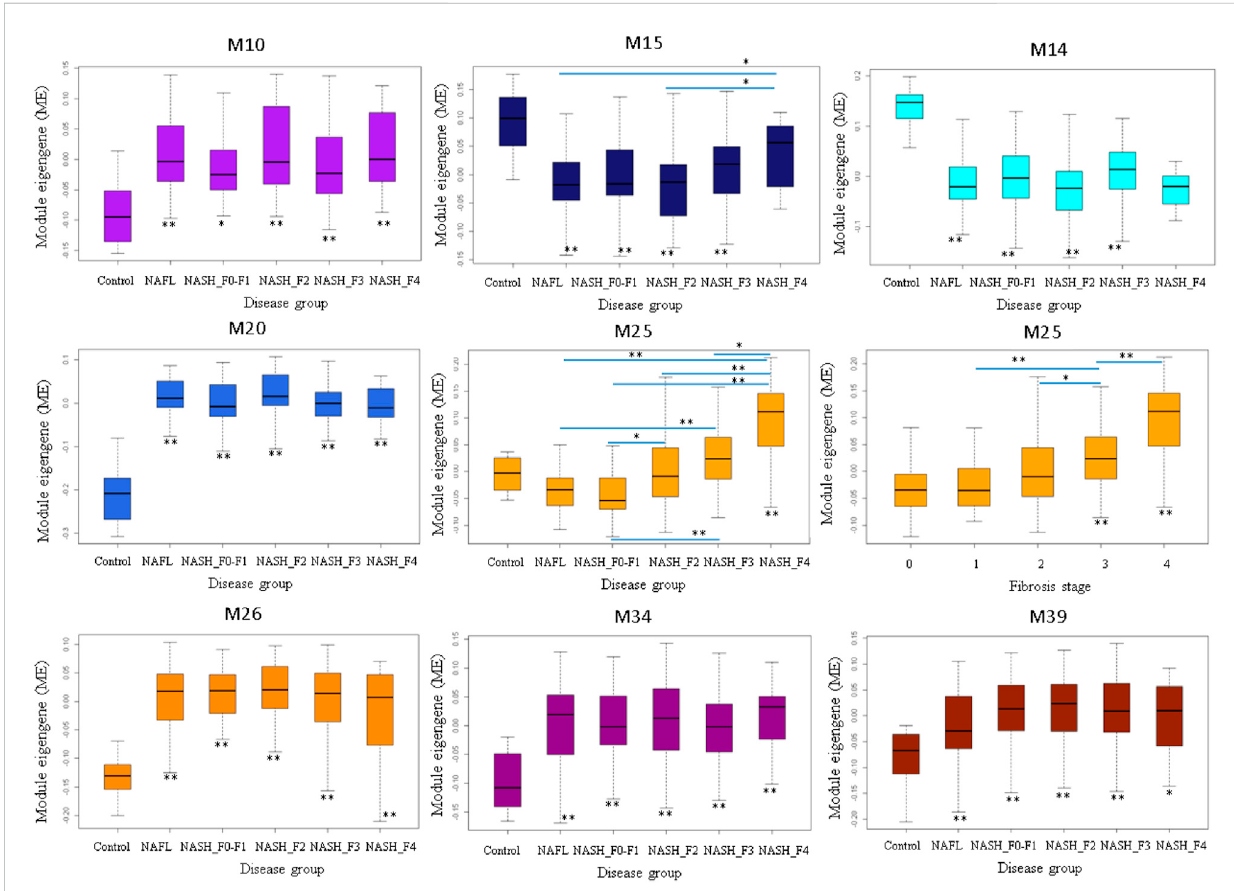
FIGURE 6 Differentially expressed modules associated with steatohepatitis stages in GSE135251. The asterisk under the box indicates the signi fi cance of the comparison between disease and normal control by ANOVA test with adjusted p values. *: p < 0.05, **: p < 0.01.